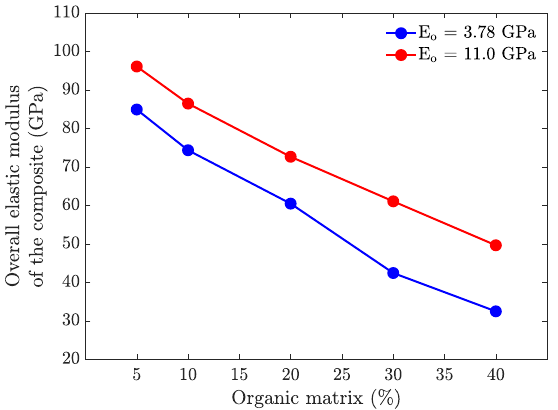
Figure 7. Trend of elastic modulus of the composites with varying percentage of the organic matrix.